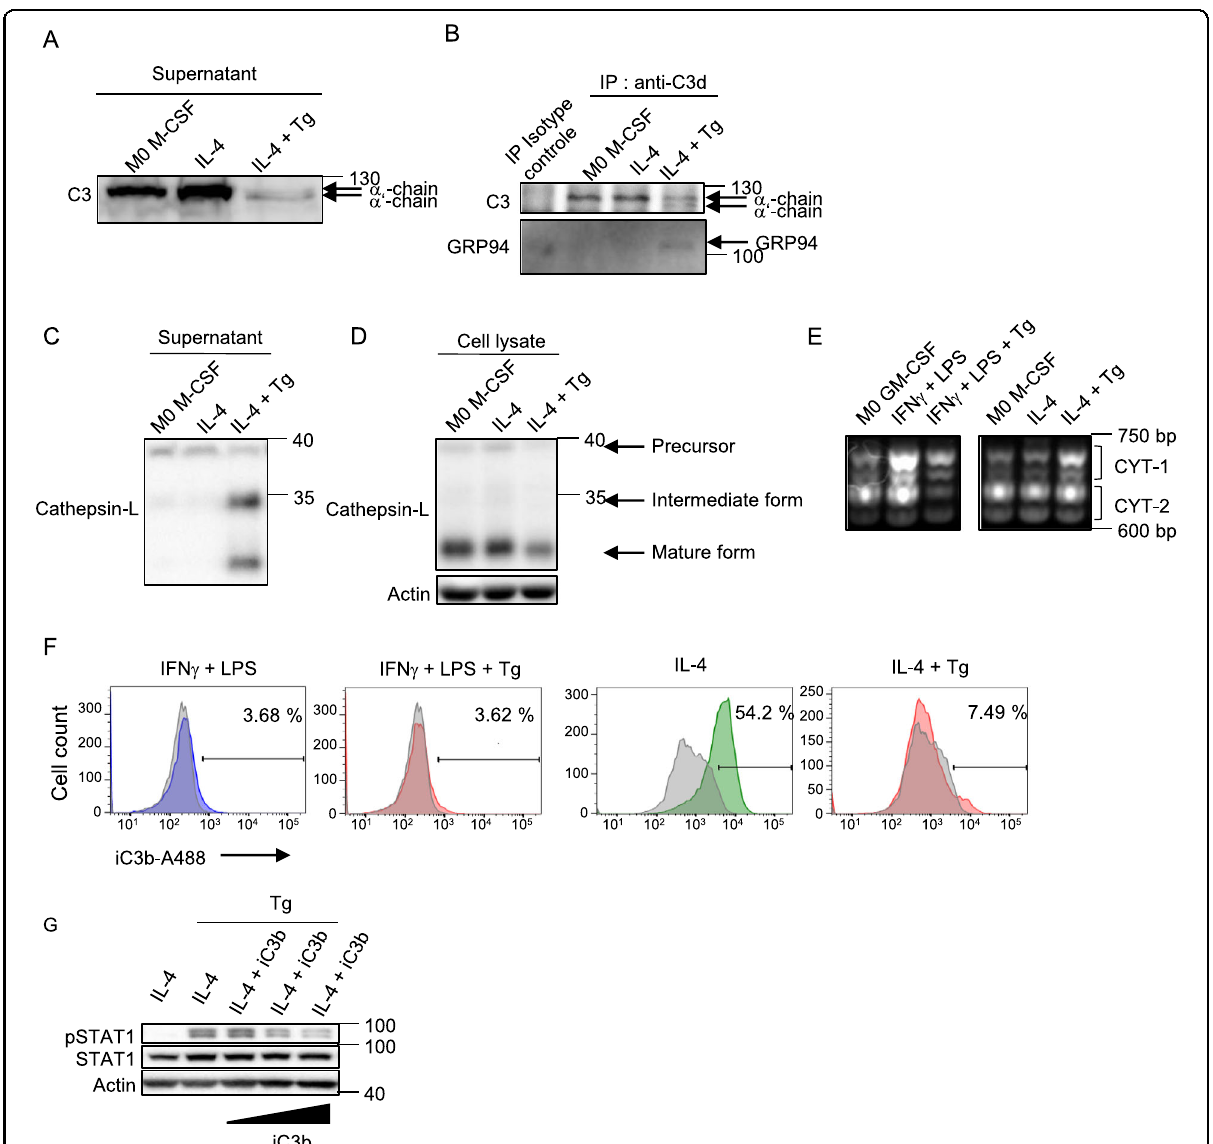
Fig. 6 C3b/iC3b balance in untreated and Tg-treated M2 macrophages. A Western-blot analysis of C3/C3b in cell culture supernatants of 48 h activated M2 macrophages treated or not with Tg ( n = 3). B Co-immunoprecipitation of C3/C3b and GRP94 in M2 macrophages supernatants using an anti-C3d polyclonal antibody ( n = 2). Western-blot analysis of cathepsin L both in cell supernatants ( n = 3) ( C ) and in cell lysates ( D ) of 48 h activated M2 macrophages treated or not with Tg ( n = 3). E CYT1 and CYT2 CD46 isoforms in M1 and M2 macrophages treated or not with Tg were analyzed by PCR ( n = 3). F iC3b membrane- bound FACS analysis on M1 and M2 macrophages treated or not with Tg ( n = 3). G Western-blot analysis of pSTAT1/STAT1 signalization proteins in M1 macrophages treated with Tg in the presence or absence of increasing amounts of recombinant iC3b (10; 100; 1000 nM) ( n =